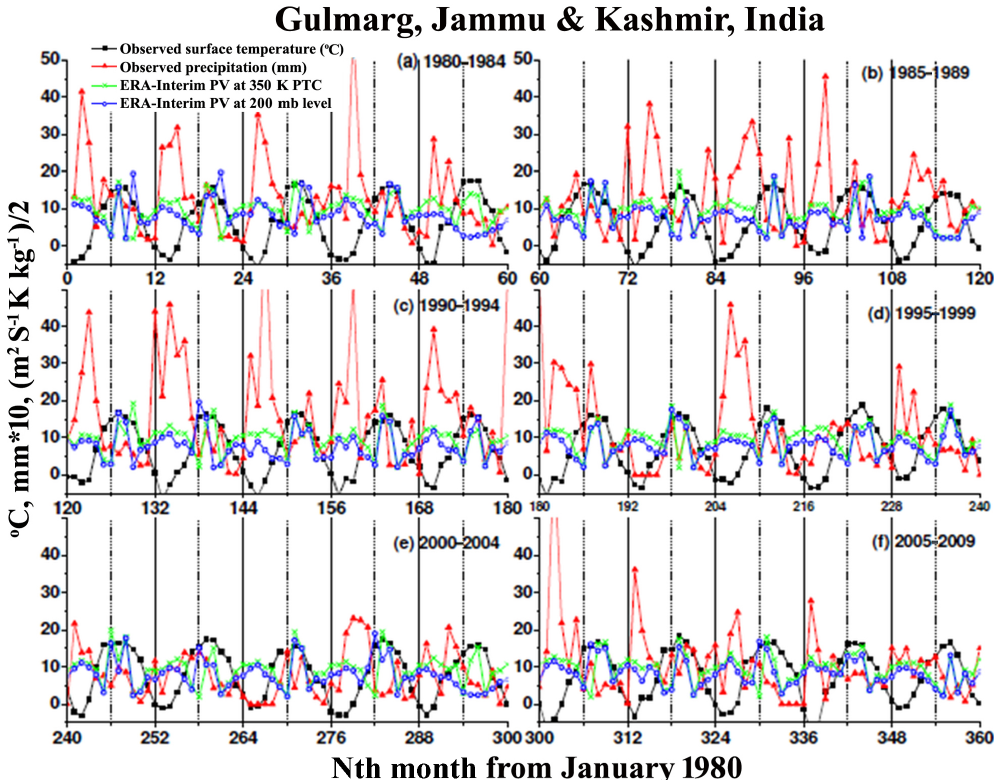
Figure 12. Same as Fig. 10 but for